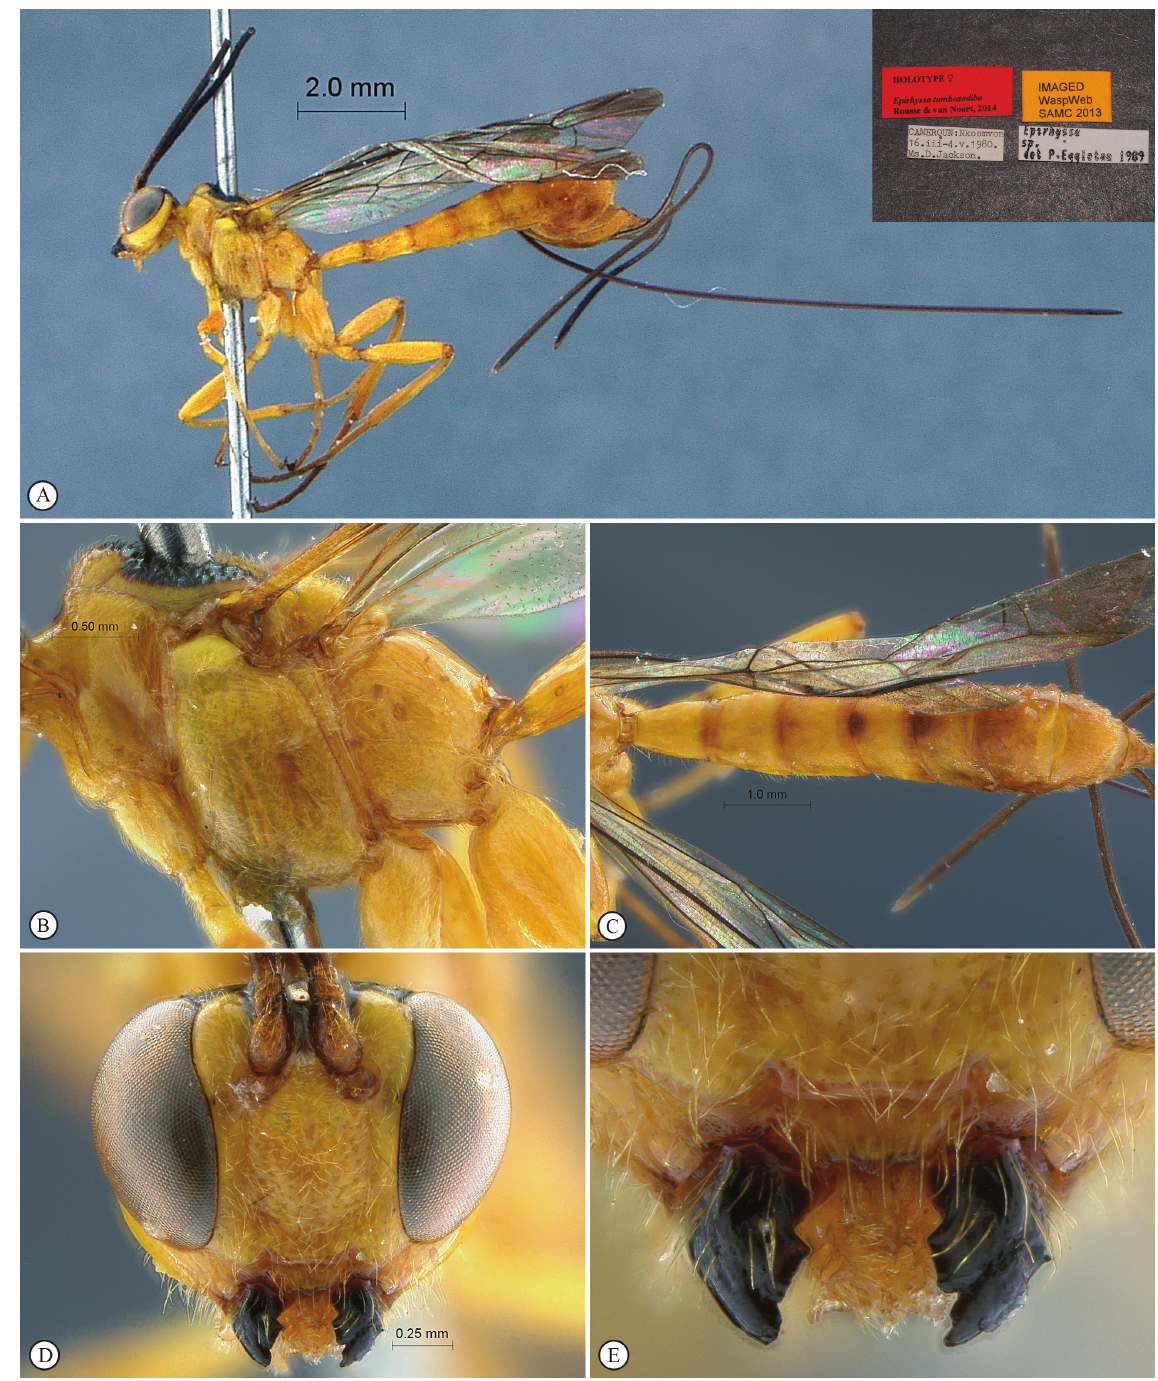
Fig. 9. Epirhyssa tombeaodiba sp. nov., holotype, ♀. A . Habitus, lateral view (inset: data labels). B . Mesosoma, lateral view. C . Metasoma, dorsal view. D . Head, anterior view. E . Mandibles, anterior